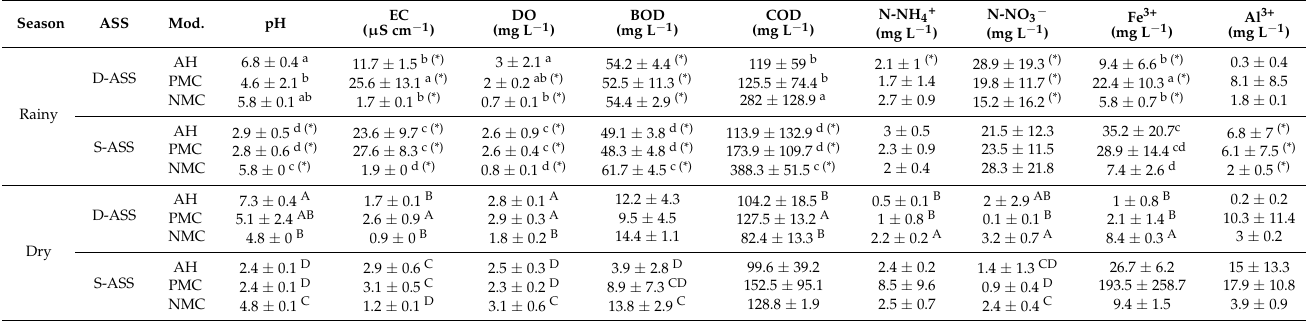
Table 1. The values of the water quality parameters of various land use